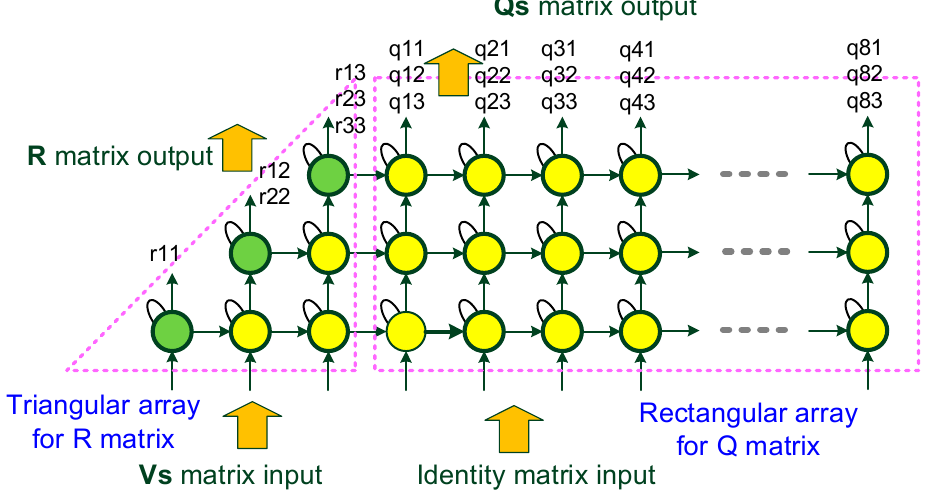
Figure 15. Systolic array design of the QR decomposition module.